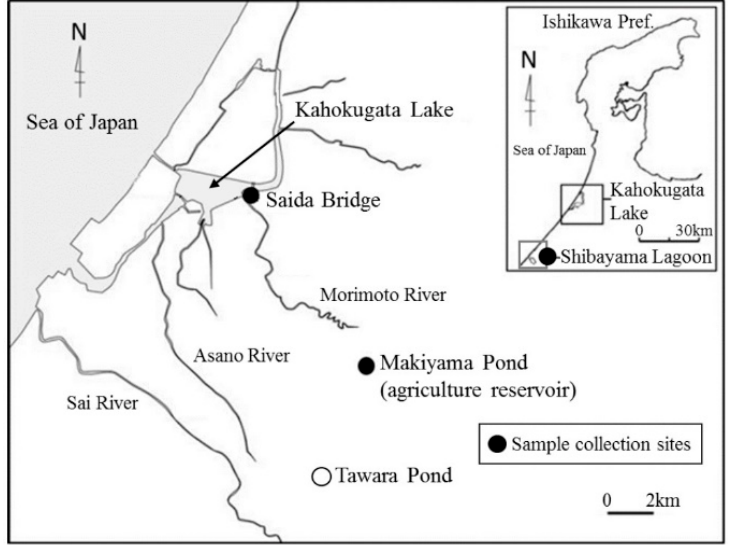
Figure 1. Location map of the study area where samples were collected in Ishikawa Prefecture, Japan.